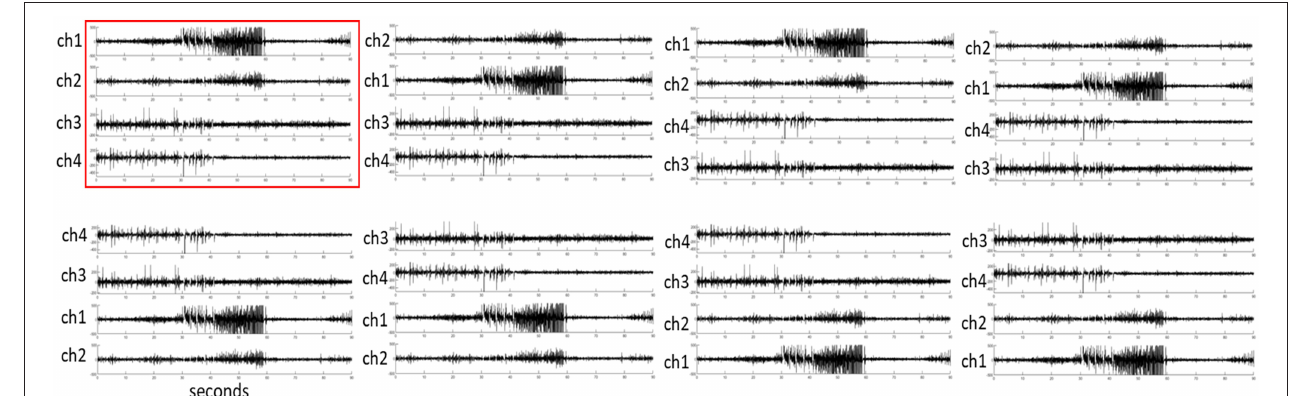
FIGURE 5 | An example iEEG record (highlighted in red) and its seven iEEG channel